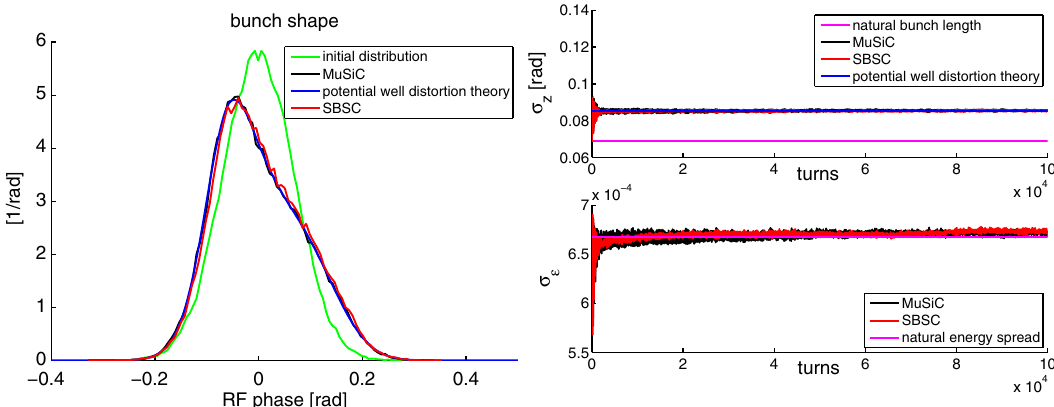
FIG. 8. Normalized bunch shape in the potential well distortion regime given by M U S I C, a single bunch code using the classical approach with wakefield and slices (SBSC), and theory (left). Comparison of rms bunch length (top, right side) and energy spread (bottom, right side) as a function of turns.